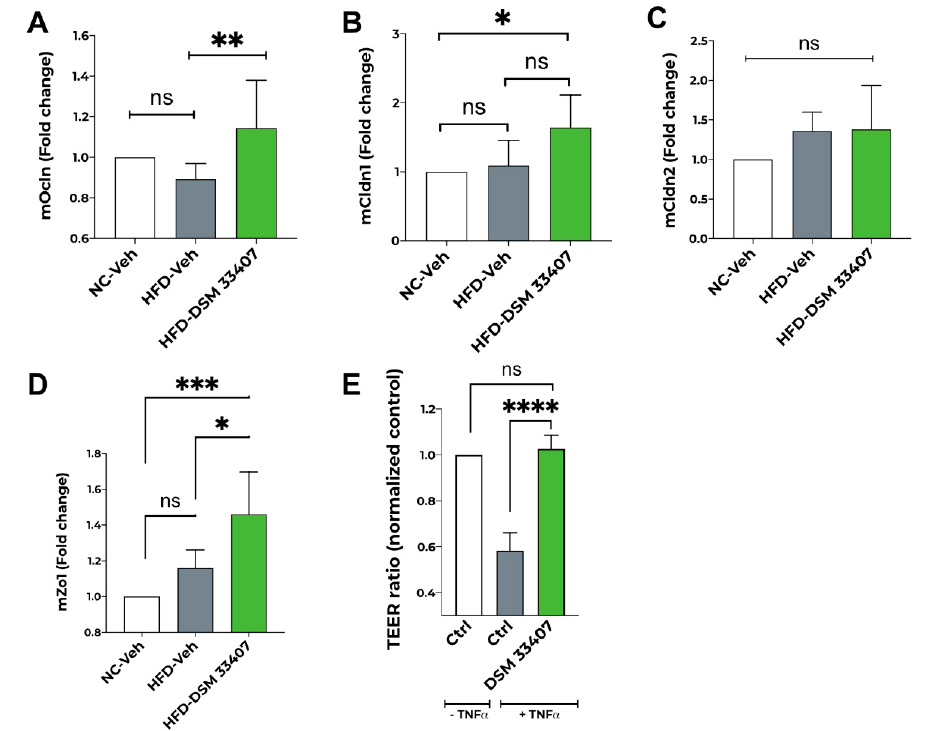
Figure 6. C. minuta DSM33407 maintains gut barrier integrity in both in vivo and in vitro preclinical models. Fold change expression of colonic tight junction proteins Occludin ( Ocln ) ( A ), Claudin 1 ( Cldn1 ) ( B ), Claudin 2 ( Cldn2 ) ( C ), and Zonula occludens-1 ( Zo1 ) ( D ) in a DIO mouse model after 40 days of treatment (n = 6). ( E ) In vitro Trans-Epithelial Electrical Resistance (TEER) upon exposure to the proinflammatory cytokine TNF-a. Statistics: one-way ANOVA followed by Tukey’s ( A – D ) or Dunett’s ( E ) multiple comparisons; for all: * p < 0.05, ** p < 0.01, *** p < 0.001, **** p < 0.0001.